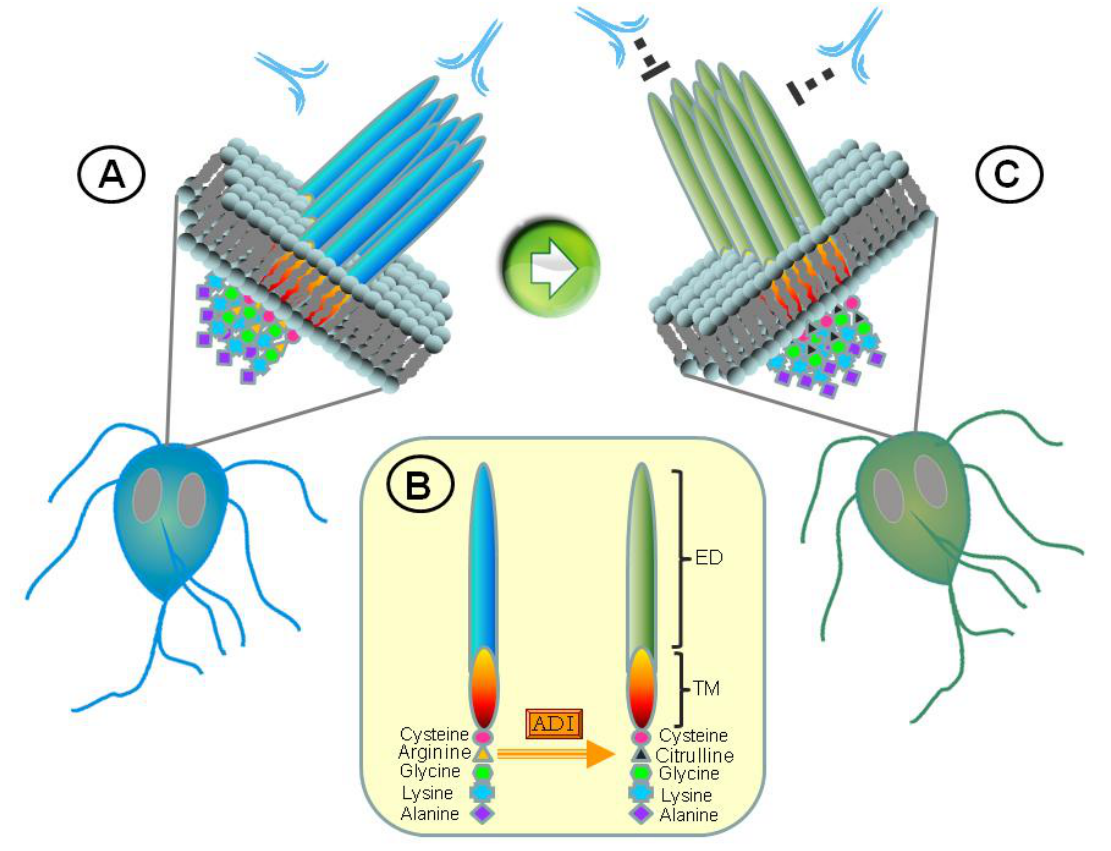
FIGURE 4. ADI is involved in the antigenic variation process of the parasite Giardia lamblia . (A) After excystation, a population of parasites that express different surface antigens appears. Each trophozoite expresses a particular VSP on its surface (in blue) against which the host produces specific antibodies. (B) ADI converts the arginine present in the cytoplasmic tail of the VSPs (in yellow) into citrulline (in gray), favoring the process of antigenic variation. (C) The expression of different VSPs (in green) by the trophozoite allows the evasion of the humoral immune response, and extends the time needed for the parasite to proliferate and differentiate in the small intestine. ED: extracellular domain; TM: transmembrane